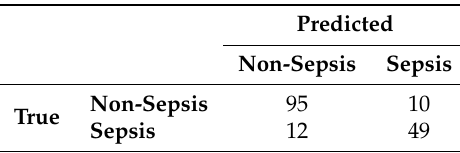
Table 13. Confusion matrix.